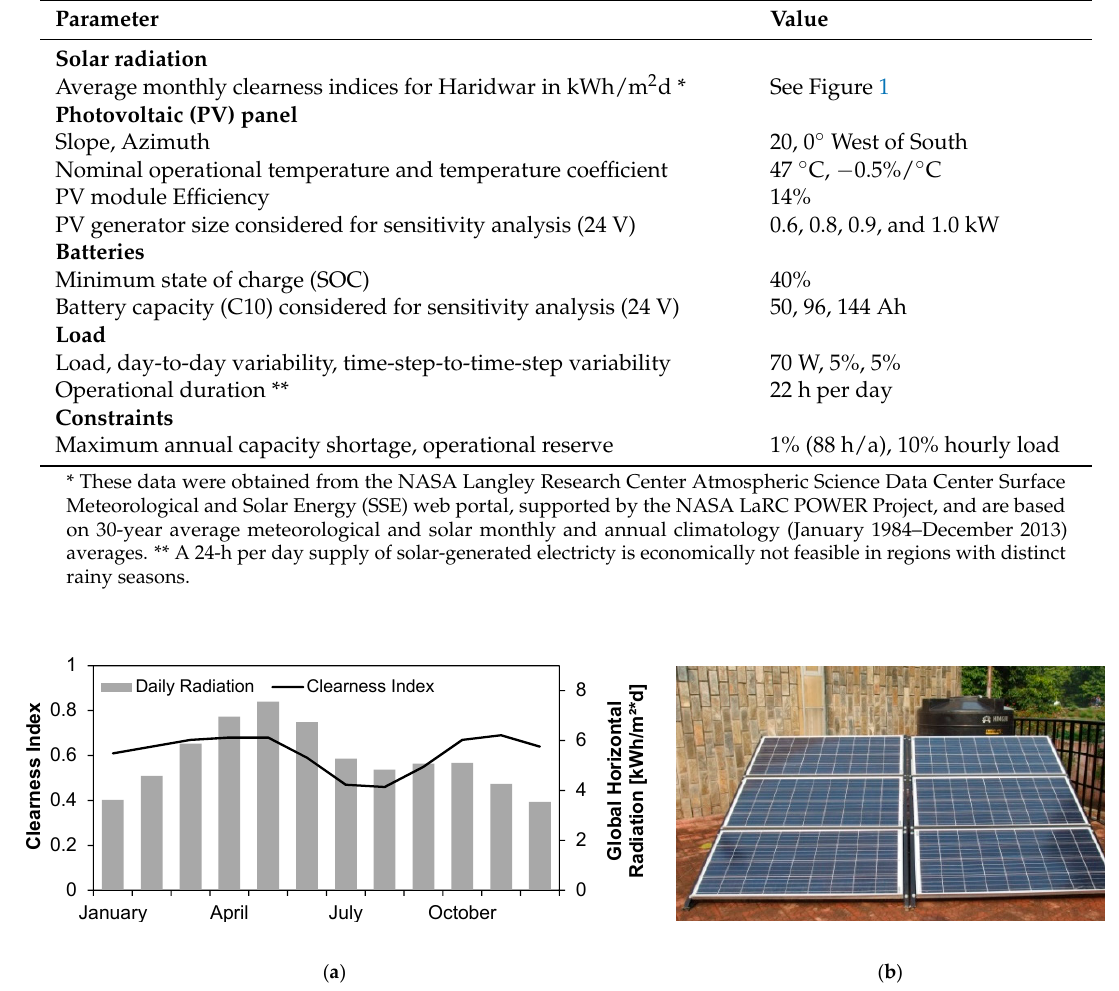
Figure 3. Clearness indices and monthly global horizontal radiation values ( a ); and the installed solar system ( b ).